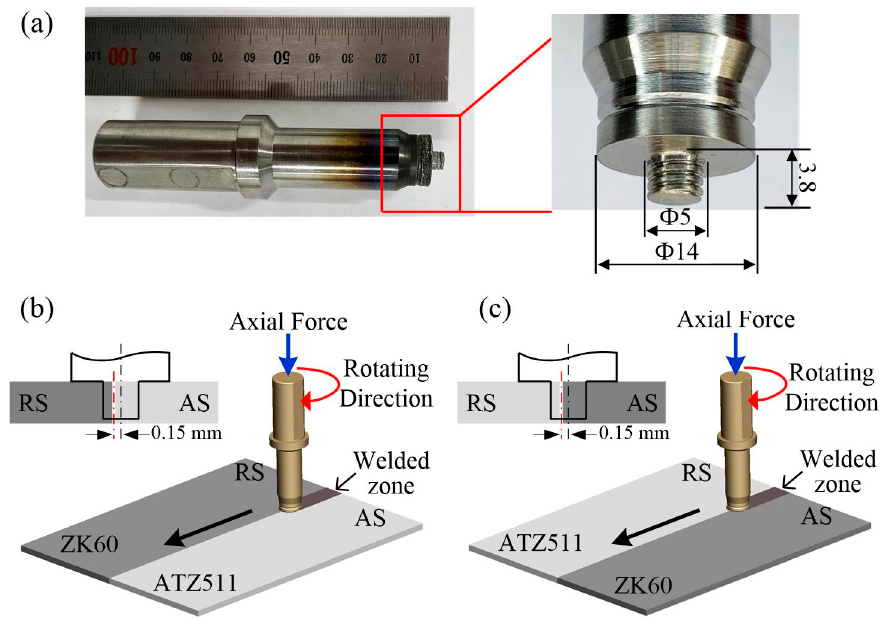
Figure 2. Pictures of rotation tool and schematics of FSW with two types of BMs arrangements: ( a ) pictures of the tool; ( b ) ZK60/ATZ511 joint; ( c ) ATZ511/ZK60 joint. (AS: advancing side; RS: retreating side).